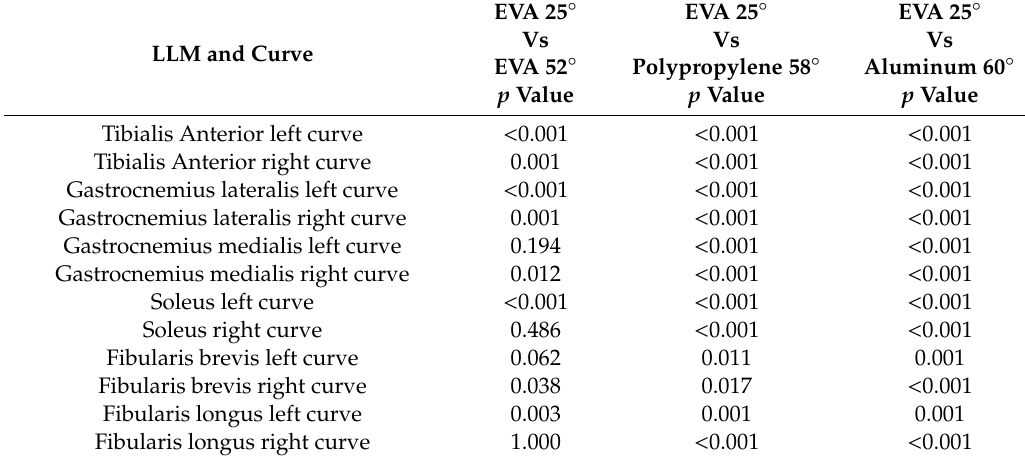
Table 5. Comparisons between types of customized foot insoles in terms of EMG activity of the lower limb muscles for left and right curves in the